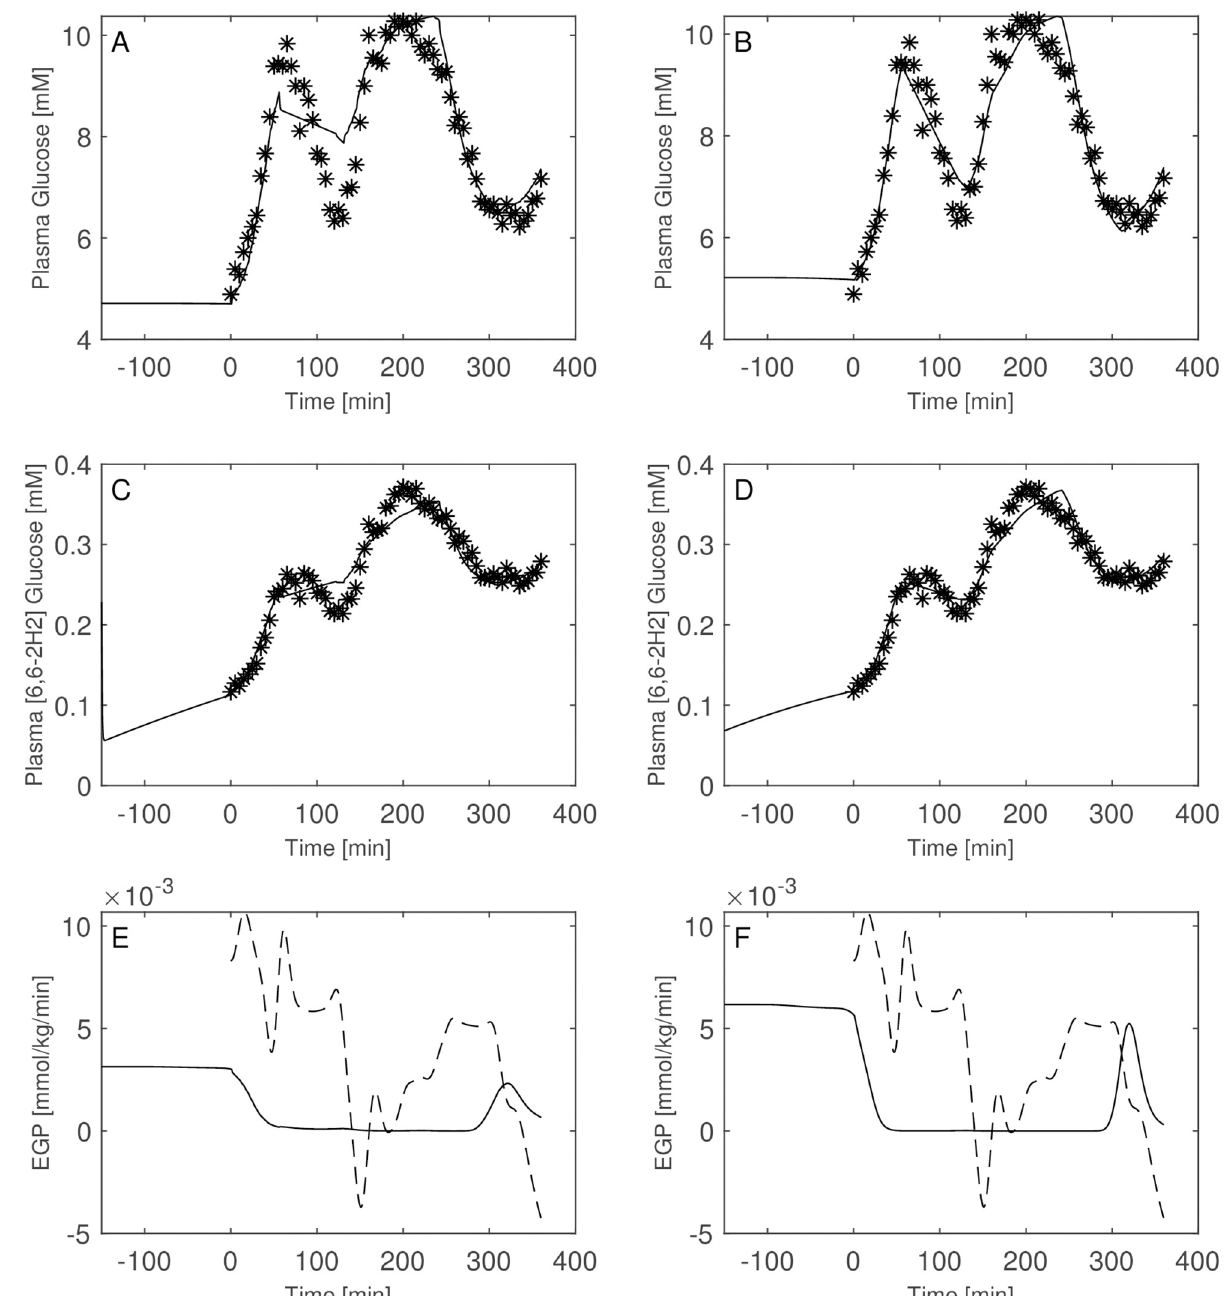
Fig 10. Model comparison for Subject 2. Observed (asterisks) and predicted (line) variables over time with glucose two-compartment model (Panels A, C, E) and one-compartments-glucose model (Panels B, D, F). Dashed line is the predicted EGP with the Steele model. All the observed points refer to data measured on day 2. Plasma glucose concentrations (panel A) are derived from the glucose intra-venous infusion to match plasma glucose observations from the OGTTs of day 1.